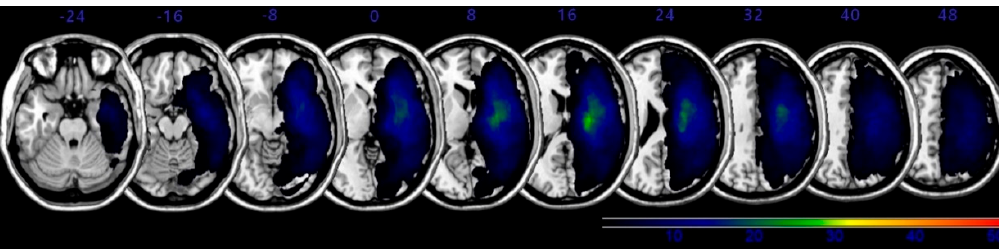
Figure 1. Lesion overlap map for all subjects (n = 50). The map of overlapping lesion areas in the brains of all stroke patients was created in standard Montreal Neurologic Institute (MNI) space. Colors denote the frequency of overlap.